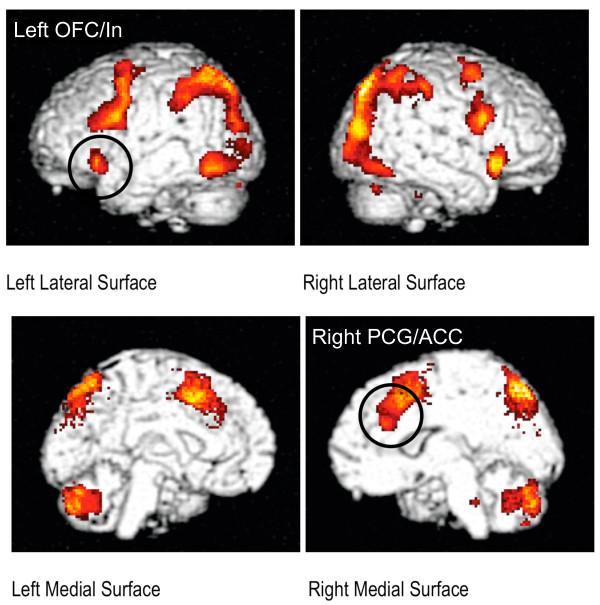
Brain Regions Demonstrating an Increased Hemodynamic Response on Incongruent Relative to Congruent Trials. Data are group-averaged across all 83 participants and shown on a rendered brain provided with SPM2. Data were thresholded at P < 0.05 (corrected) and a minimum cluster size of 10 contiguous voxels. The left OFC/In and right PCG/ACC both contributed significantly to our model predicting change in physiological falls risk.